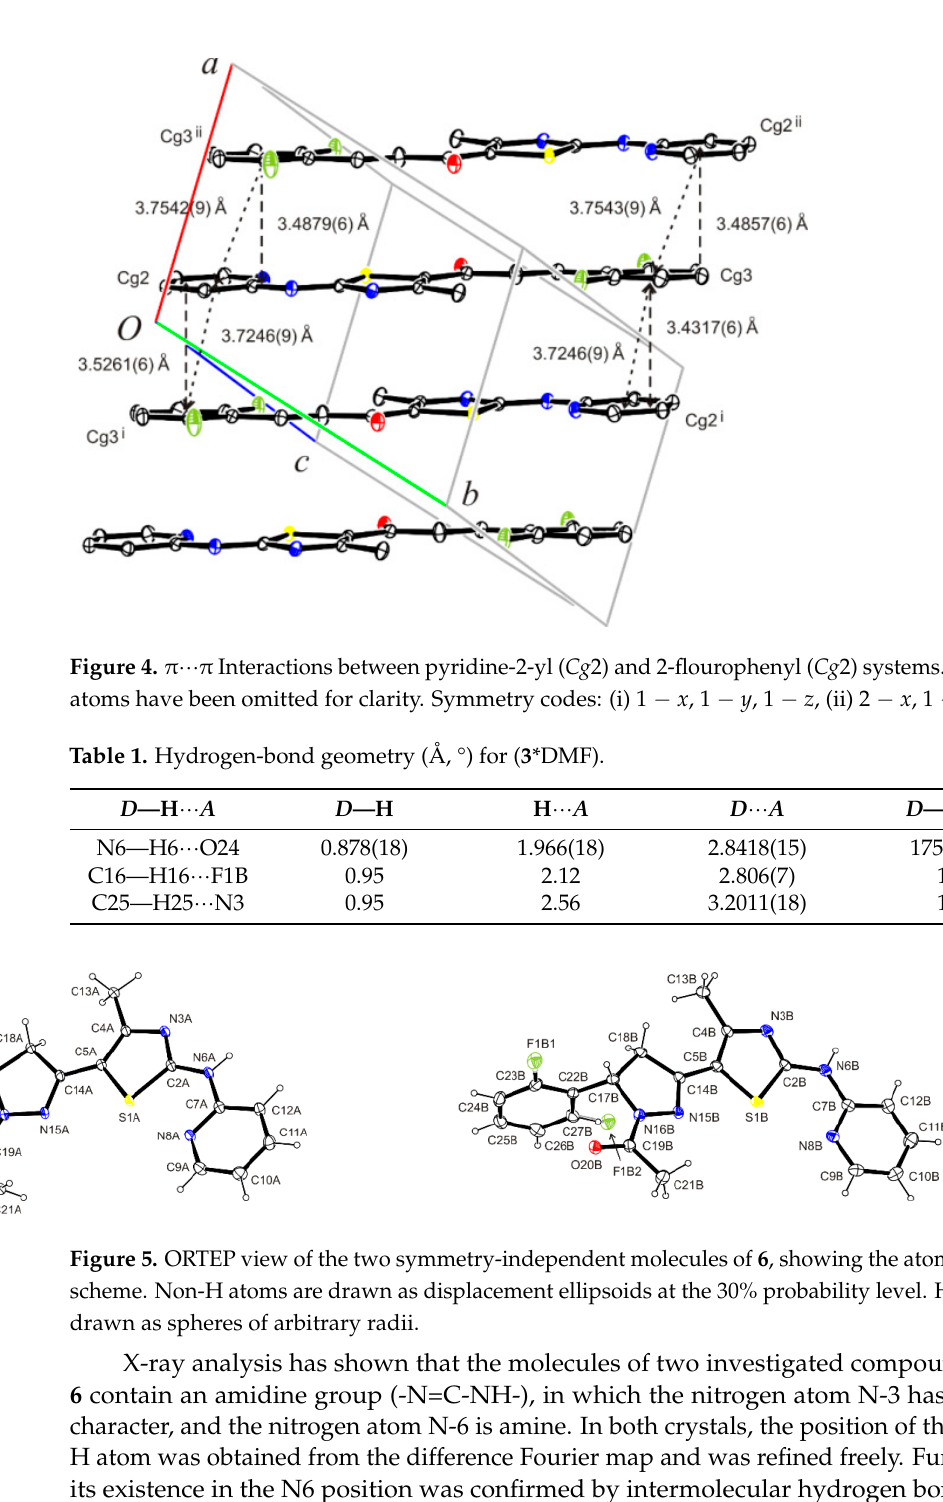
Figure 6. ( a ) Overlay of two symmetry-independent molecules A (red) and B (blue) by the least-squares fitting of the 4-methyl-1,3-tiazole systems; ( b ) 3D stick representation with indicated planes of phenyl ring in molecules A (pink plane) and B (blue plane). In the crystal lattice of 6 , layers parallel to the ab plane are formed separately by molecules A and B, and B molecules are observed (Figure 7). The molecules A and B from neighboring layers are linked by N6A-H6A···O20B, N6B0H6B···O20A i , C21B-H21B···N3A and C21A-H21E···N3B ii hydrogen bonds into chains growing along the [011 ̅ ] direction. Apart from hydrogen bonds in the crystal, the interactions of C9A ― H9A··· Cg 1 iii and C18-H18C··· Cg2 iv are also observed. The interactions connect chains of molecules to form the layers that grow parallel to the (011) plane.